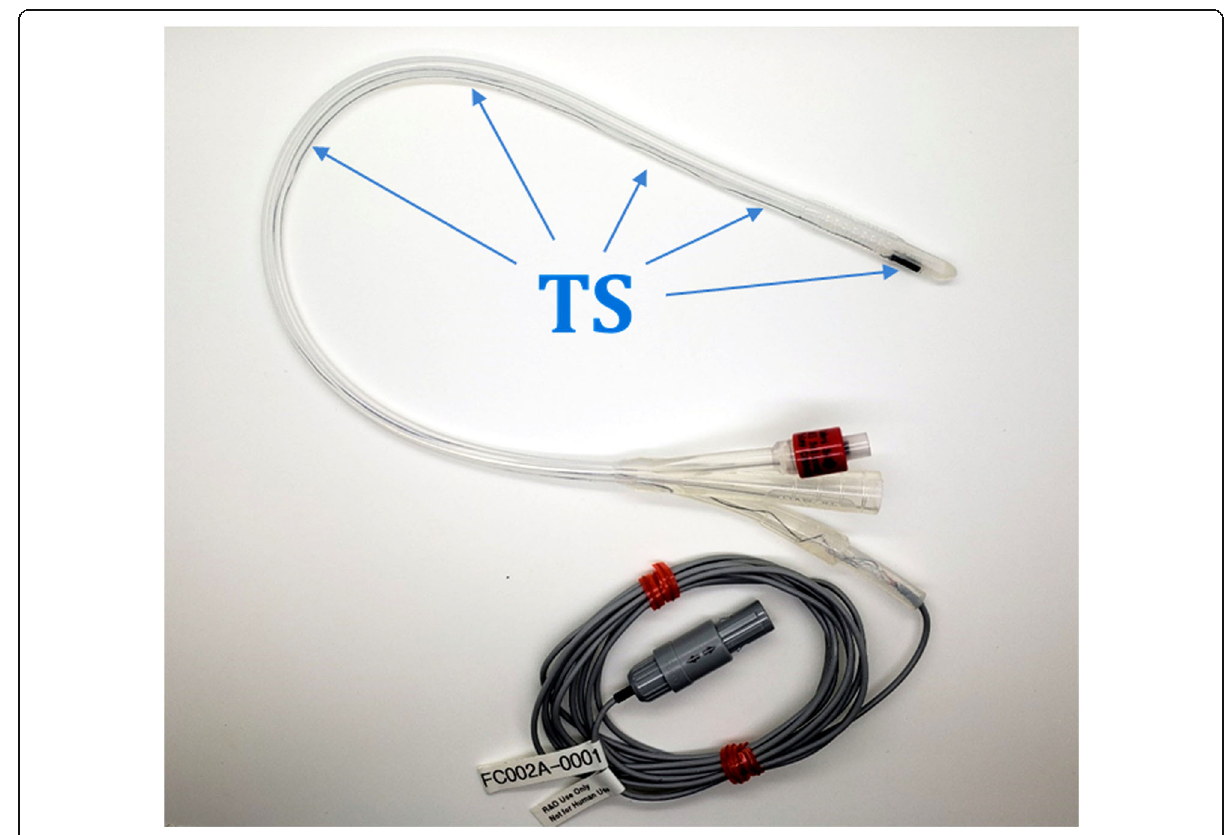
Fig. 2 Tracked Foley catheter (TFC) prototype. The TFC has a six degrees of freedom (forward/backward, up/down, left/right, and rotational movement along x , y , and z axes) tracking sensor (TS) that assumes a complex shape in the urethra and provides real-time tracking